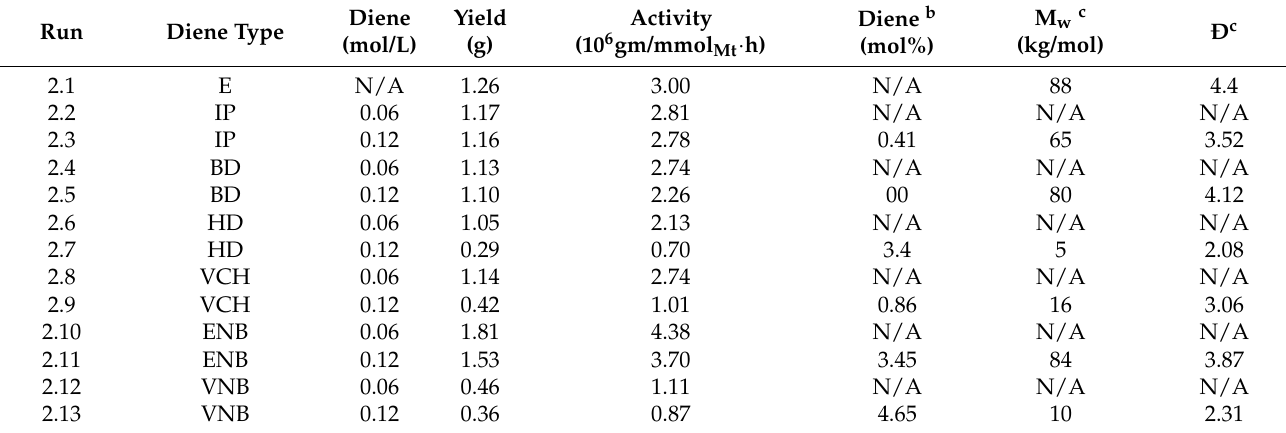
Table 2. Ethylene-diene copolymerizations with rac -Et(Ind) 2 ZrCl 2 (complex B)/Ph 3 C][B(C 6 F 5 ) 4 /TIBA a . Run Diene